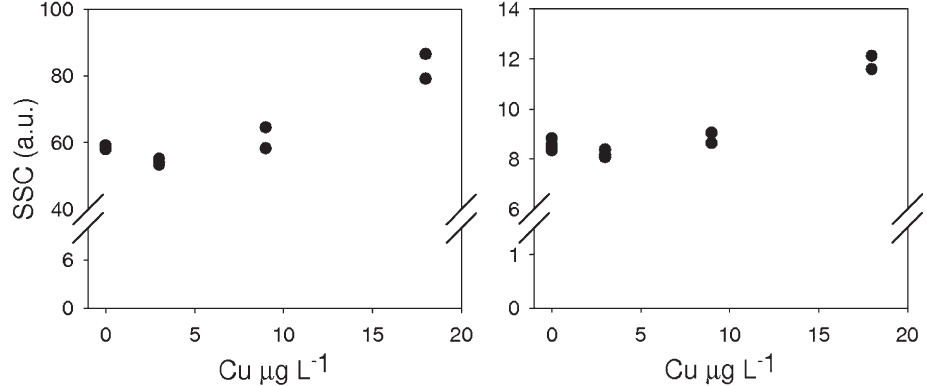
Fig . 8. – SSC arbitrary unit variations with increase in copper exposure for sample O4. The dot plot on the left corresponds to the picoeu- karyote population and the one on the right to the prokaryote population with FL2.